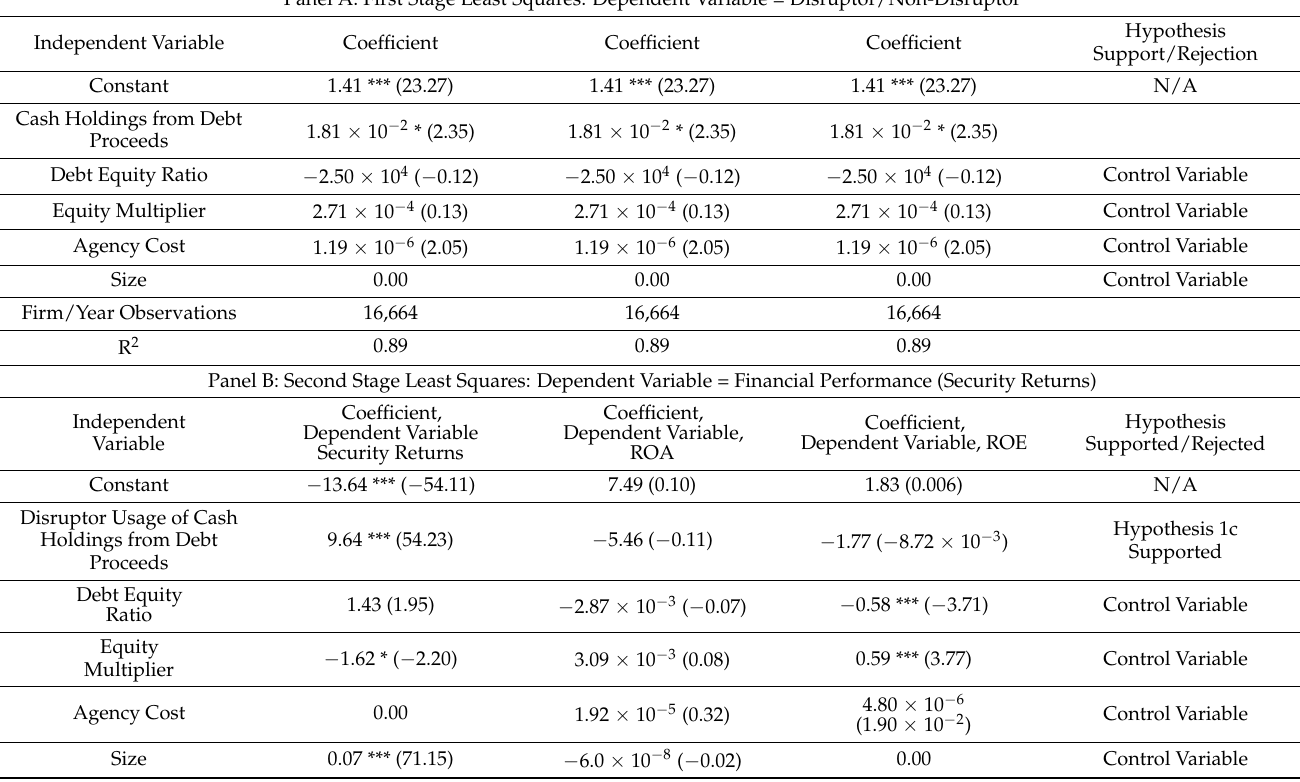
Table 4. Two-Stage Least Squares Regressions of Cash Holdings from Debt Proceeds on Disruption, Followed by Disruption on Financial Performance (Full